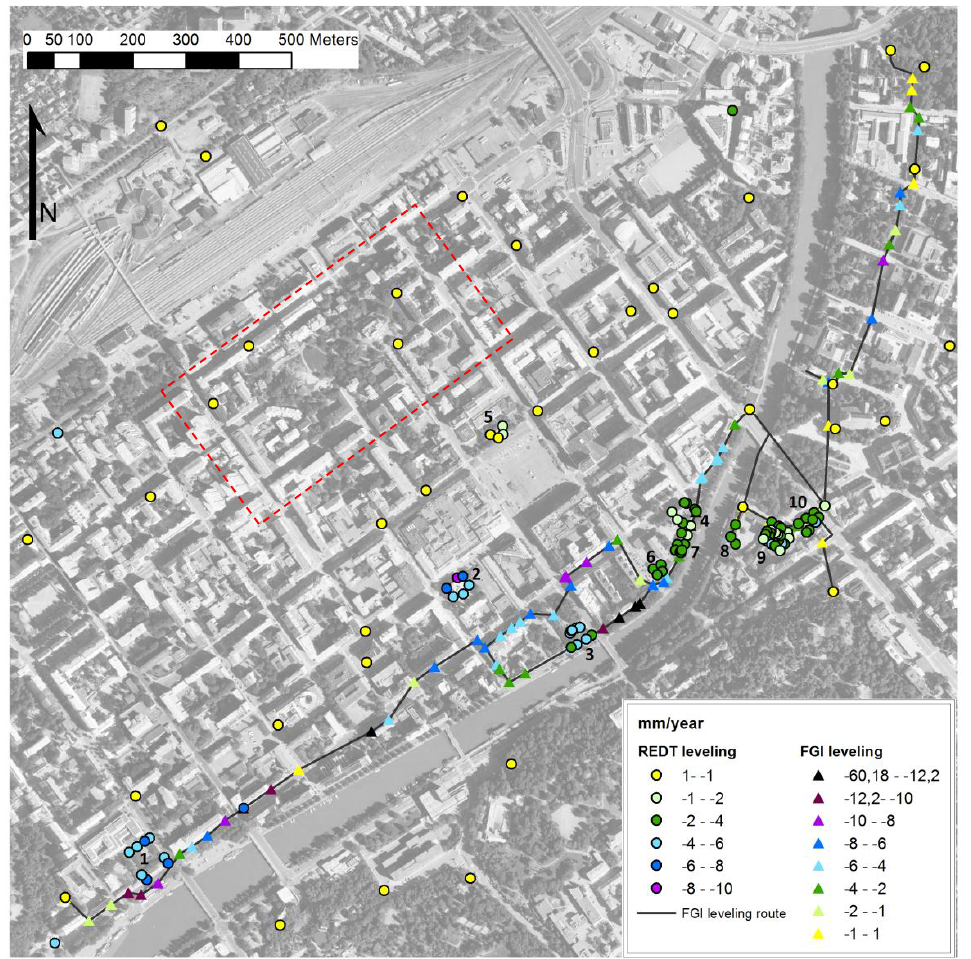
Figure 3. Real Estate Department of Turku (REDT) and Finnish Geodetic Institute(FGI) leveling benchmarks and their vertical deformation rates in the area. Yellow is stable point. Red square marks the approximate position of the initial atmosphere estimate. Numbers